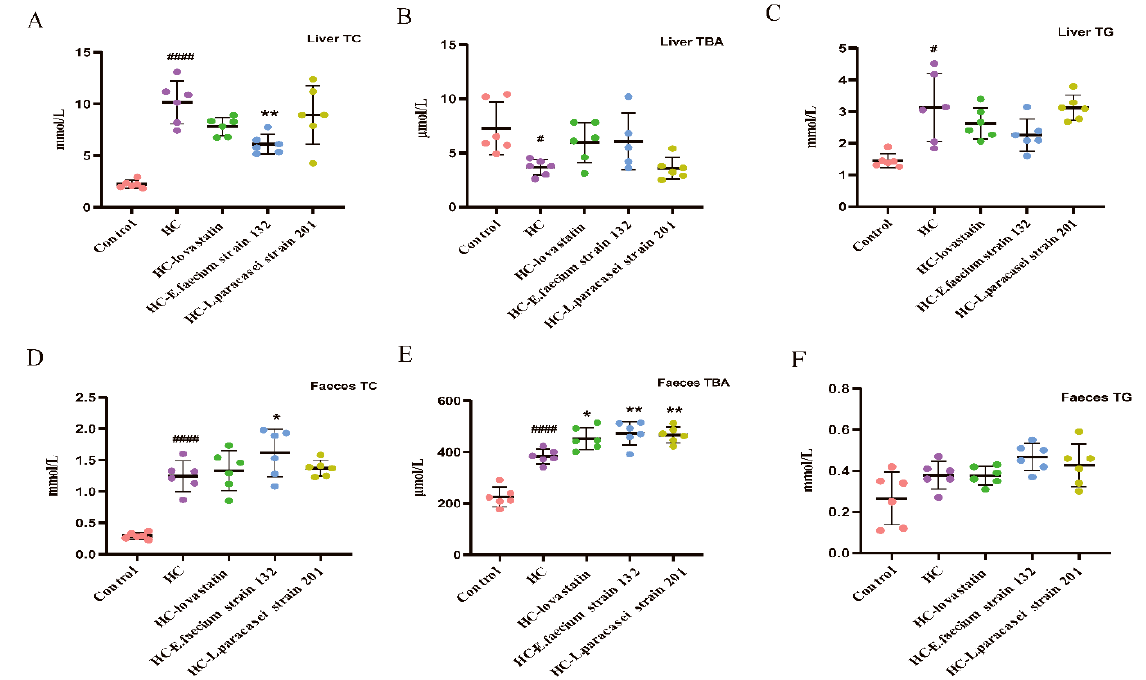
Figure 1. Levels of total bile acids (TBA), triglycerides (TG) and total cholesterol (TC) in feces and liver. ( A ) TC level in liver. ( B ) TBA level in liver. ( C ) TG level in liver. ( D ) TC level in feces. ( E ) TBA level in feces. ( F ) TG level in feces. Data are expressed as the mean ± SD of triplicate tests. ( n = 6 for weight gained, TC, TG and TBA in feces and liver). The pink bar represents the control group, the purple bar represents the HC group, the green bar represents the HC-lovastatin group, the blue bar represents the HC- E. faecium strain 132 group and the yellowish-brown bar represents the HC- L. paracasei strain 201group. p -values were determined using a one-way ANOVA with Tukey’s test for post-hoc analysis. Significant differences between the HC group versus control group are indicated as # p < 0.05, #### p < 0.0001. Significant differences in the HC-lovastatin, HC- E. faecium strain 132 or HC- L. paracasei strain 201 group versus HC group are indicated as * p < 0.05, ** p < 0.01.